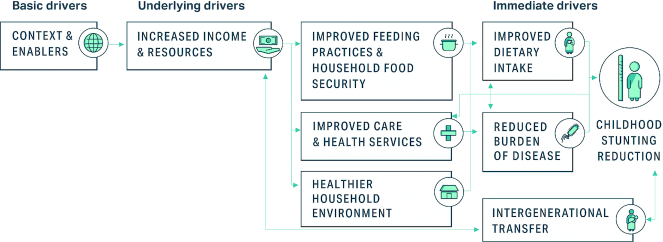
Conceptual framework for analyzing determinants of child nutrition. Adapted from references 21, 6, and 7.